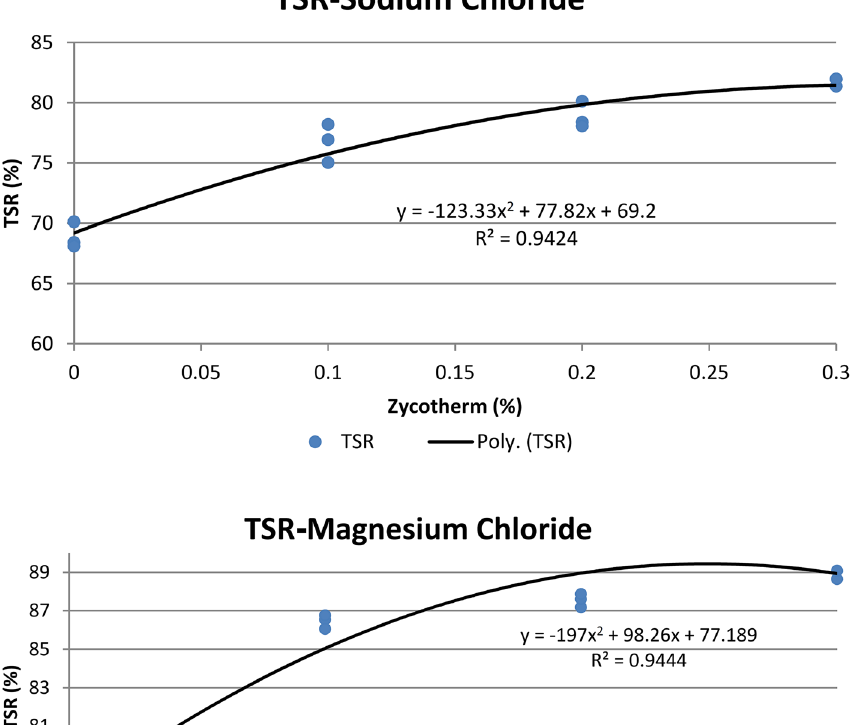
Fig. 11 Regression model of TSR for samples saturated with sodium chloride solution